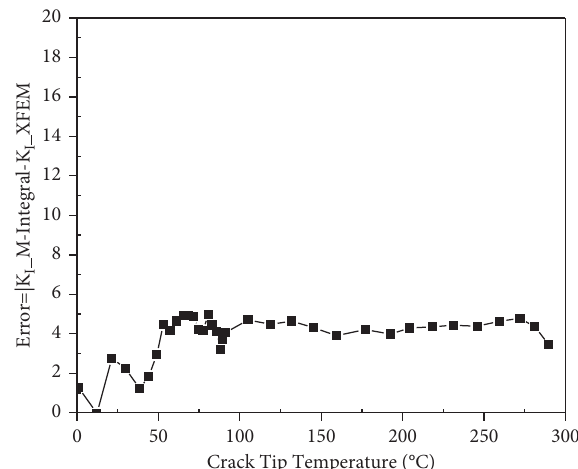
Figure 19: Error between the M-integral and XFEM K